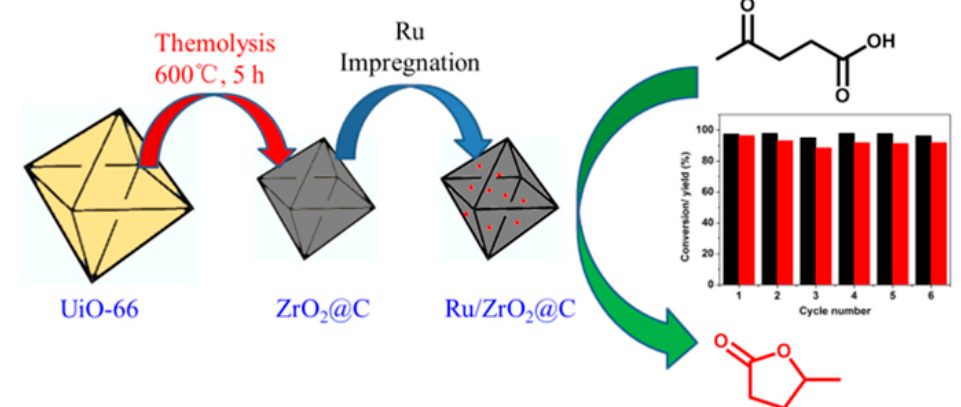
Figure 2. Synthesis and durability of metal organic framework (MOF)-derived Ru single-atom catalyst (SAC). Reprinted with permission from Ref [20]. Copyright 2017, The Royal Society of Chemistry.